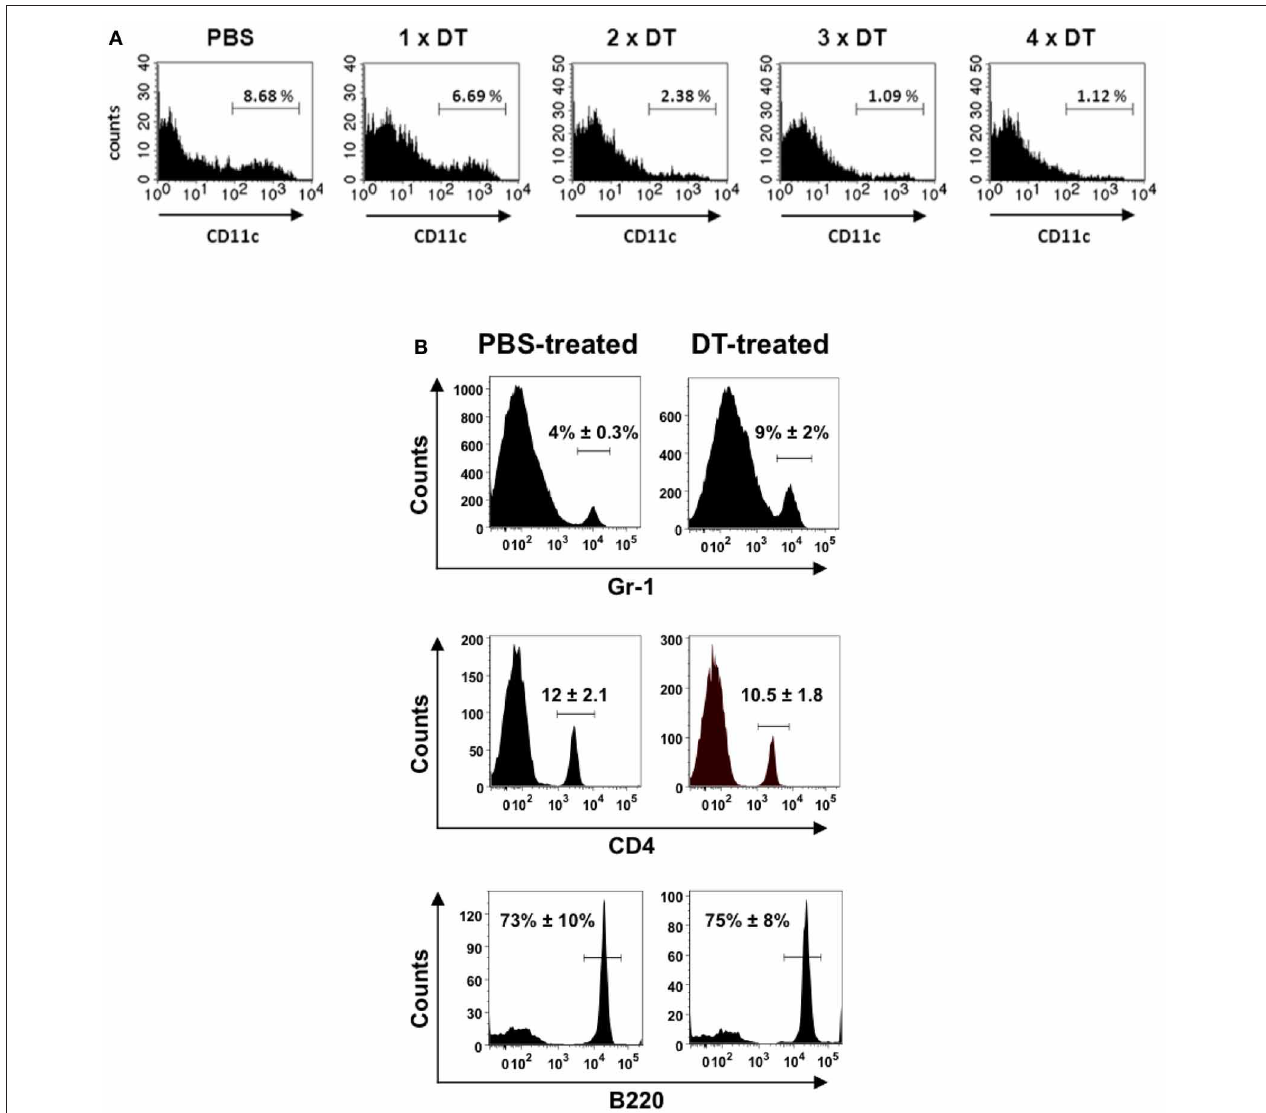
FIGURE 1 | Depletion of CD11c + cells in the lungs of CD11c-DTR chimera mice after treatment with successive doses of DT. CD11c-DTR mice were injected with 1, 2, 3, or 4 successive doses of DT (8 ng/g body weight) or PBS. Lungs were digested and transformed in single cell suspensions 24h after treatment and stained with PE-conjugated anti-CD11c antibodies for FACS analysis. (A) Representative histogram of CD11c expression in lung